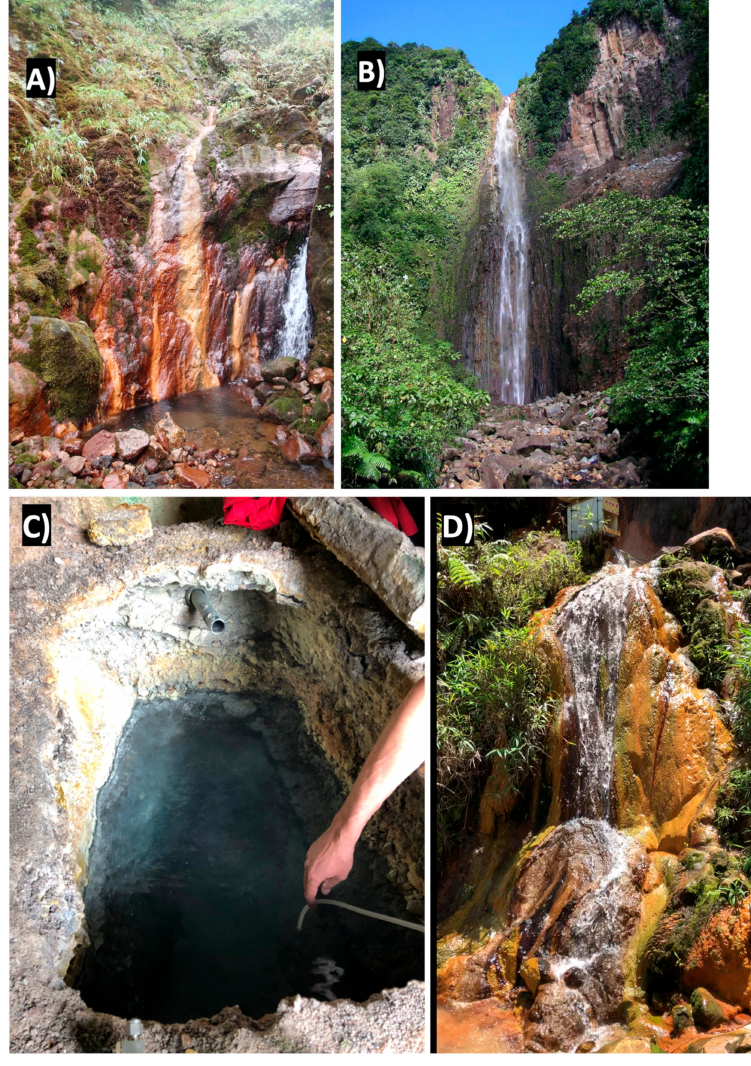
Figure 9. Images of selected hot springs from Soufri è re–Grande D é couverte complex (courtesy of the OVSG-IPGP). ( A ) Carbet Echelle; ( B ) Deuxi è me Chute du Carbet; ( C ) Bains Chaudes-Matouba; and ( D )